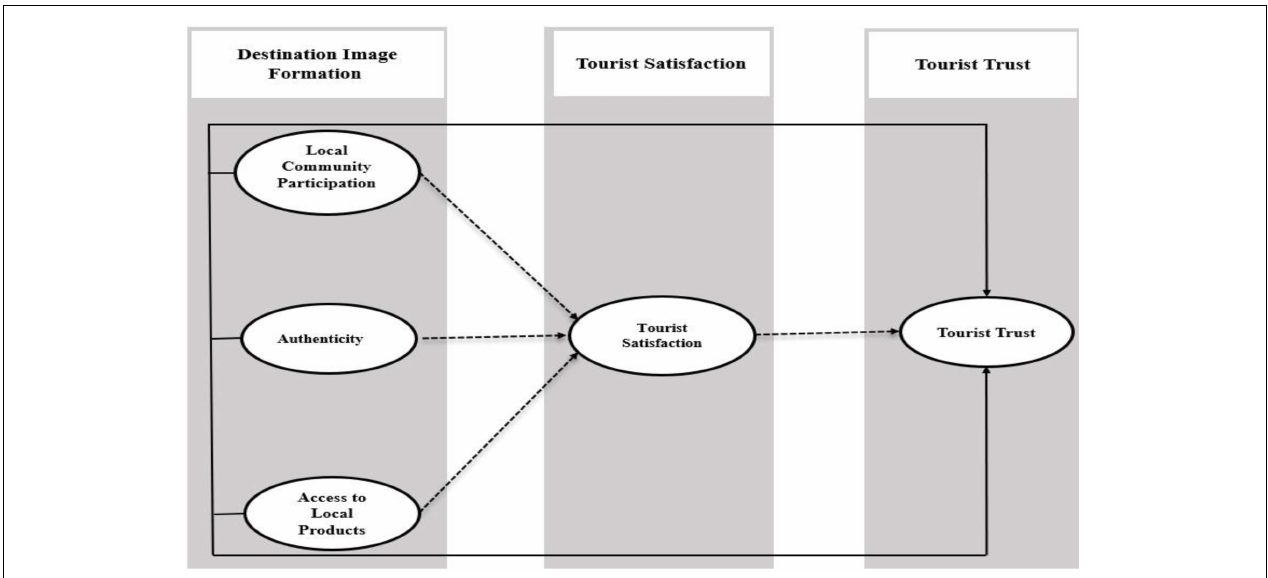
FIGURE 1 | Conceptual